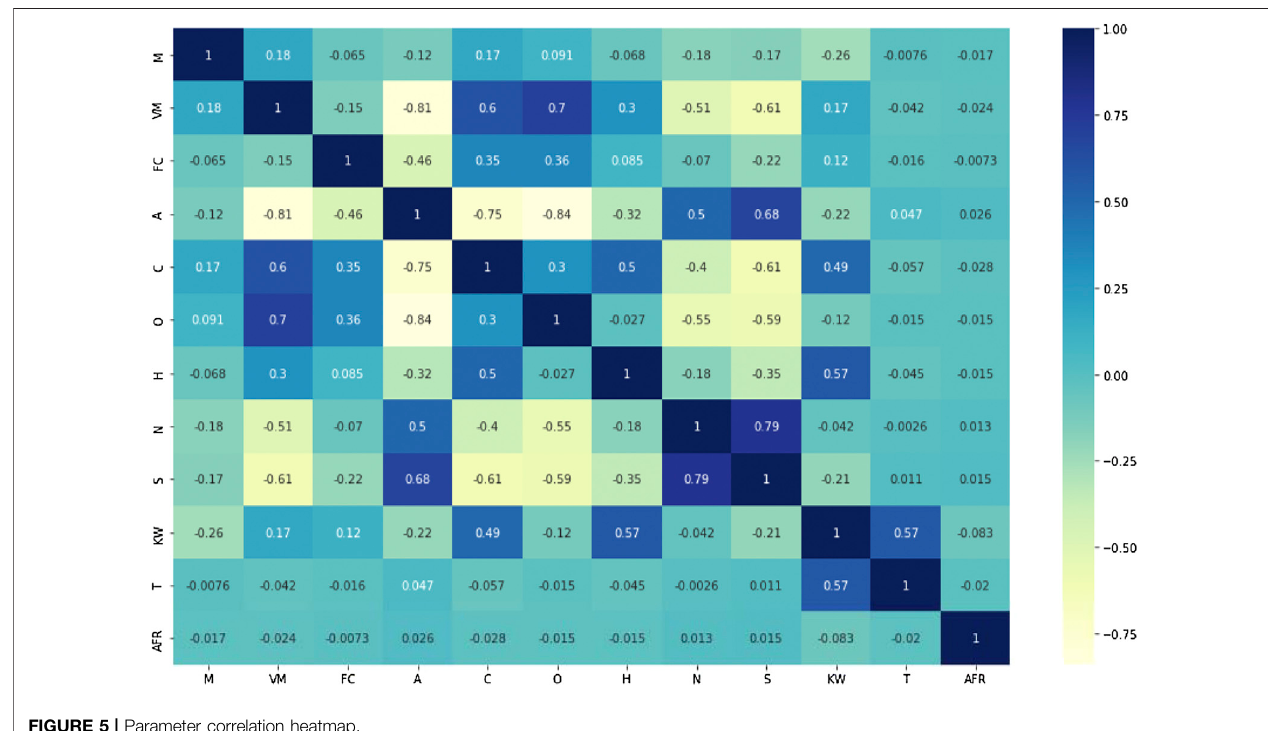
FIGURE 5 | Parameter correlation heatmap.